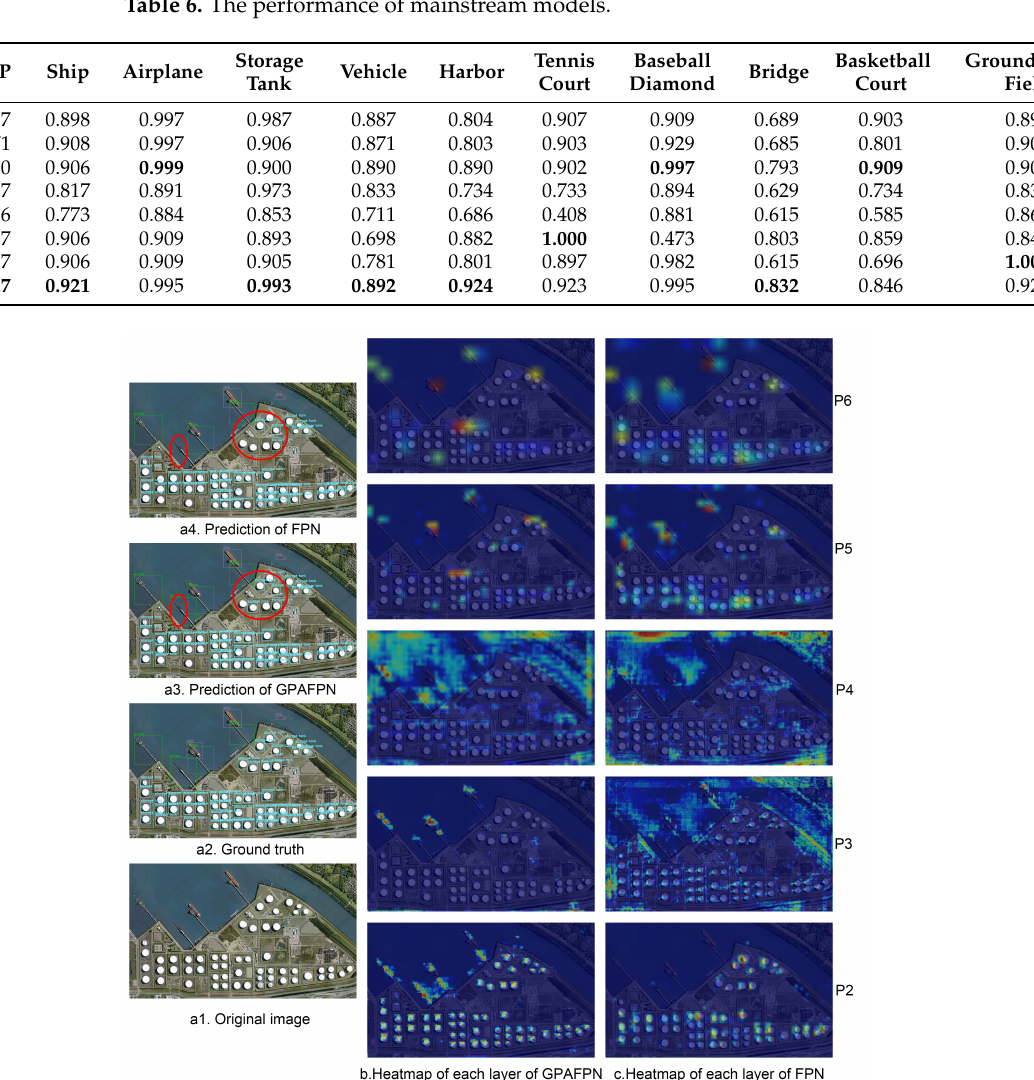
Figure 6. Performance of different feature layers of GPAFPN and